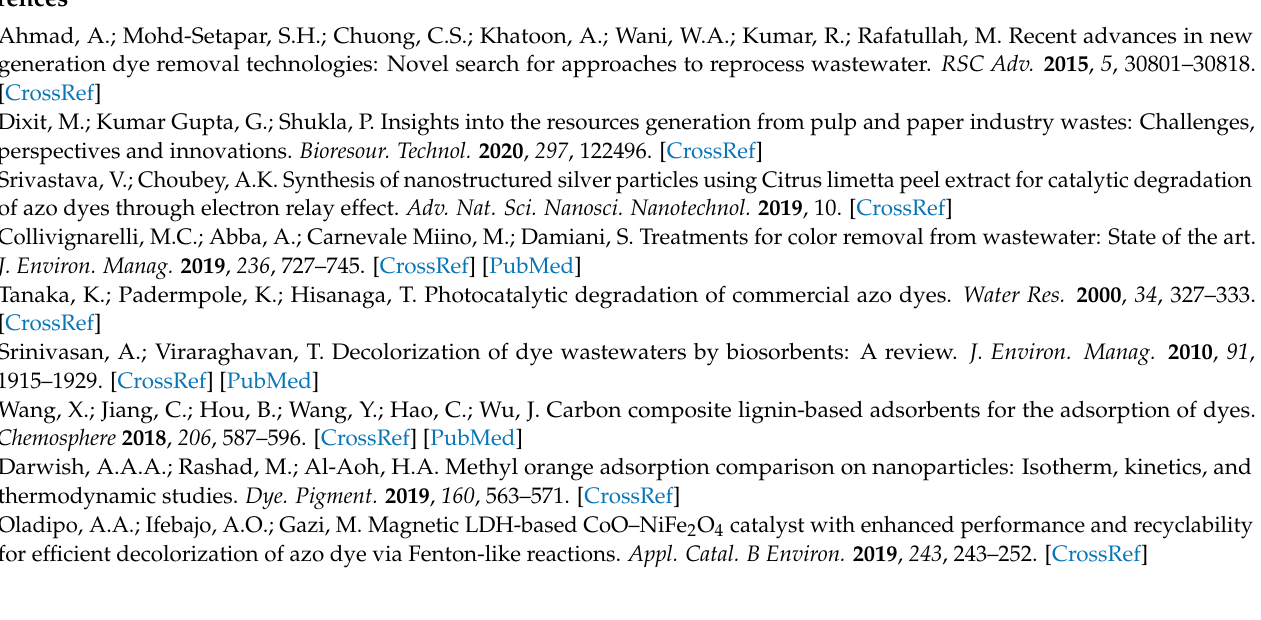
Figure S3: EDS spectra of CSB800. Figure S4: EDS spectra of RCB800-2. Figure S5: TEM images of (a) RCB800, (b) BSB800, and (c) CSB800. Figure S6: XRD spectra of RCB800, BSB800, CSB800, and CNT. Figure S7: FTIR spectra of biochar materials. Figure S8: Degradation of MO (0.5 mM) by sulfide (6 mM) with RCB800 and RCB800 without washing. The dosage of materials was 100 mg/L, pH = 7.4, and the temperature was 30 ◦ C. Figure S9: Degradation of MO (0.5 mM) by sulfide (6 mM) with (a) RCB800, (b) RCB800-2, used twice, and (c) RCB800-3, used three times. The dosage of materials was 100 mg/L, pH = 7.4, and the temperature was 30 ◦ C. Figure S10: Degradation of MR (0.5 mM) by sulfide (6 mM) with RCB800 and the control experiment. The dosage of materials was 100 mg/L, pH = 7.4, and the temperature was 30 ◦ C. Figure S11: Degradation of MO (0.5 mM) by sulfide (6 mM) with RCB800 and CNT. The dosage of materials was 100 mg/L, pH = 7.4, and the temperature was 30 ◦ C. Figure S12: UV-vis spectrograms of MR and MO. Table S1: Fraction of different types of Carbon of material surface from XPS spectra (at. %). Table S2: Fraction of different types of Oxygen of material surface from XPS spectra (at. %). Table S3: Degradation parameters of MO by sulfide with RCB800. Table S4: Degradation parameters of MO by sulfide with RCB800 at 20 ◦ C, 30 ◦ C, and 40 ◦ C. Table S5: Degradation parameters of MO by sulfide with RCB800 at pH = 6.2, 7.4, 8.1, and 10.2. Table S6: Degradation parameters of MO by sulfide with RCB800 and by polysulfides. Table S7: Degradation parameters of MO by sulfide with zeolite and AQDS. Table S8: Degradation parameters of MO by different concentrations of sulfide. Table S9: Degradation parameters of different concentrations of MO by sulfide. Table S10: Degradation parameters of MO by sulfide with RCB800 for different times of use. Table S11: Degradation parameters of MR by